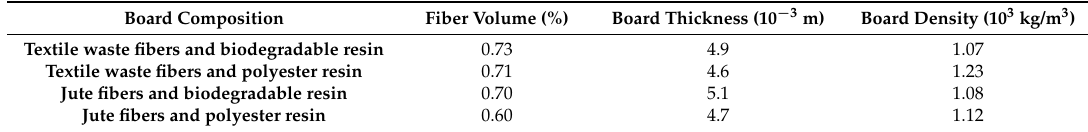
Table 3. Characteristics of green composite boards.